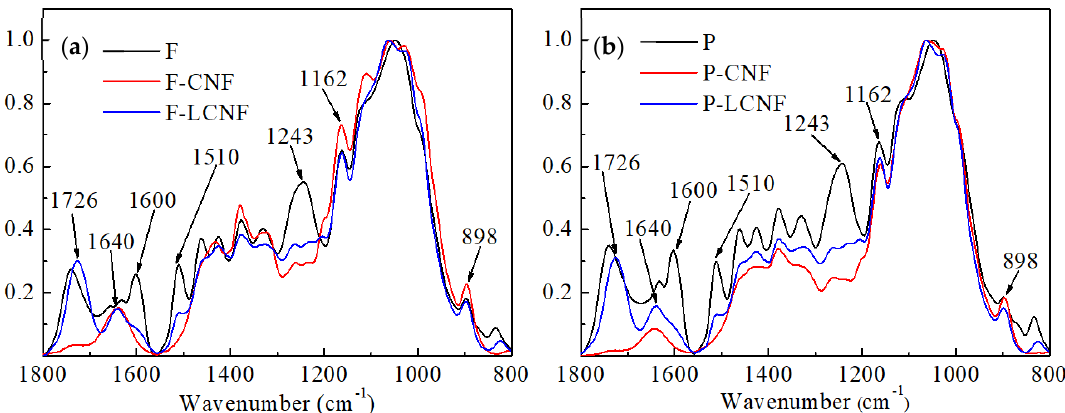
Figure 2. FTIR spectra of samples at different stages from fibers ( a ) and parenchyma cells ( b ).